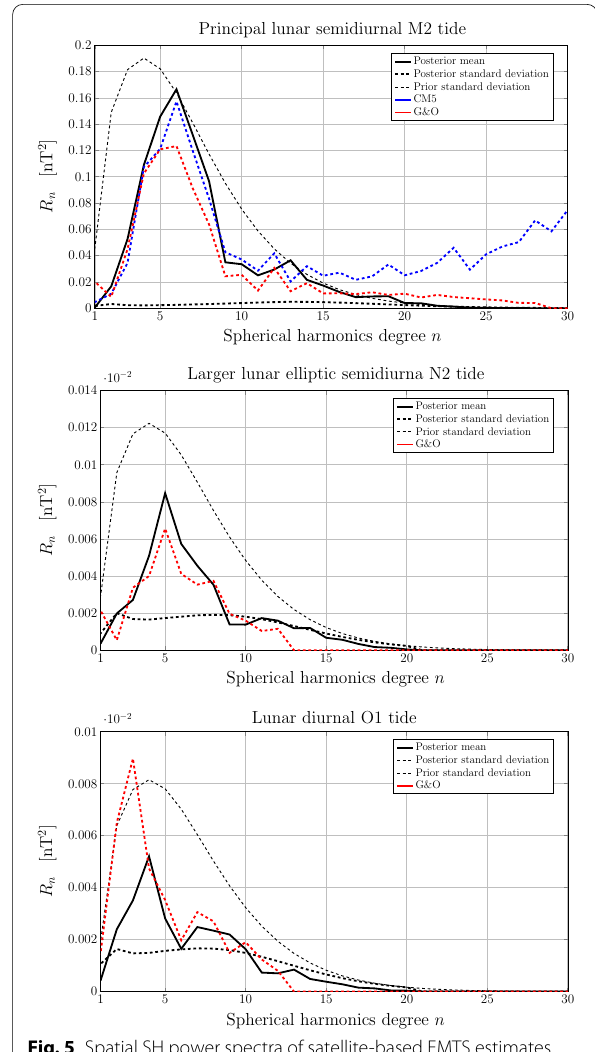
Fig. 5 Spatial SH power spectra of satellite‑based EMTS estimates. From top to bottom: M2, N2 and O1. Black lines: KALMAG estimates (solid) with prior and posterior standard deviation (light and solid dashes). Blue: CM5 estimates from Sabaka et al. (2015), i.e., mostly 12 years of CHAMP data. Red: Estimates from Grayver and Olsen (2019), i.e., 15 years of CHAMP and Swarm data. For better comparability with the literature, all fields are represented at sea level (cf., Grayver and Olsen 2019; Sabaka et al.